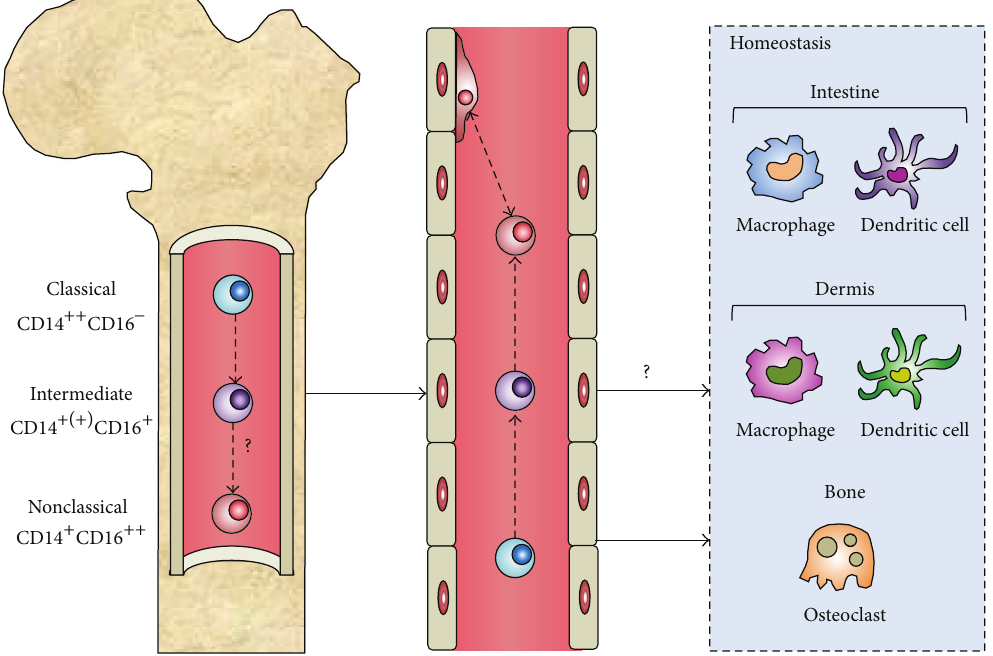
Figure 1: The origin and differentiation of peripheral blood monocytes. Monocytes are generated from hematopoietic stem cells in the bone marrow (left) and enter the blood stream (middle) in response to different microenvironmental cues. In homeostasis, classical monocytes are continuously recruited to populate DC and macrophage levels in the intestine and dermis and bone-degrading osteoclasts at the bone surface. It remains unknown whether intermediate monocytes contribute to populations of monocyte-derived immune cells in homeostasis. Nonclassical monocytes patrol the endothelium and do not contribute to the maintenance of populations of mature immune cells in